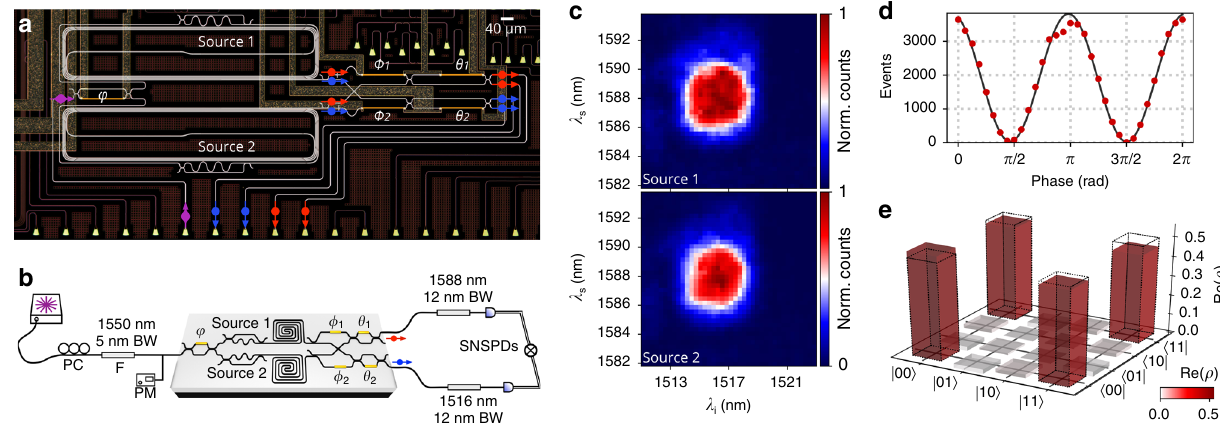
Fig. 2 Multiple sources and indistinguishability characterisation. a Optical microscope image of the device for the coherent pumping of two sources and processing of the emitted photons. Input pump light is split between the two sources via an input MZI. Waveguide crossings are used to group the signal and idler photons emitted from both sources, and arbitrary unitary operations on signals (idlers) are implemented via a phase-shifter ϕ 1 ( ϕ 2 ) and a MZI with internal phase θ 1 ( θ 2 ). b Schematic of the integrated circuit and set-up to characterise the indistinguishability between the sources. c Individual JSIs measured with separate pumping of source 1 (top panel) and source 2 (bottom panel). The indistinguishability of the two measured spectra, calculated with the overlap of the two JSIs, is 0.985(1). d Measured reverse-HOM fringe from the two sources. Error bars, from Poissonian photon statistics, are smaller than markers. The fringe visibility, which corresponds to source indistinguishability, is 0.987(2). e Density matrix of the two-qubit entangled state obtained when coherently pumping the two sources, reconstructed via quantum state tomography. Fidelity with the ideal state Φ þ pictured as transparent bars, is 0.989(3). The source indistinguishability inferred from the tomography is 0.982(6).